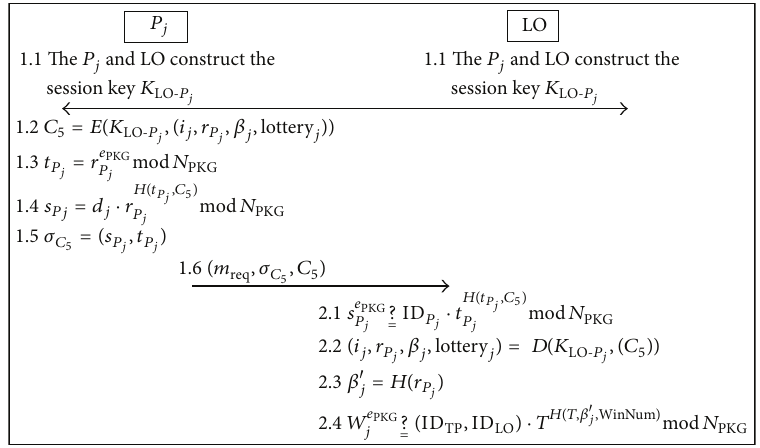
Figure 6: Overview of the claim prize